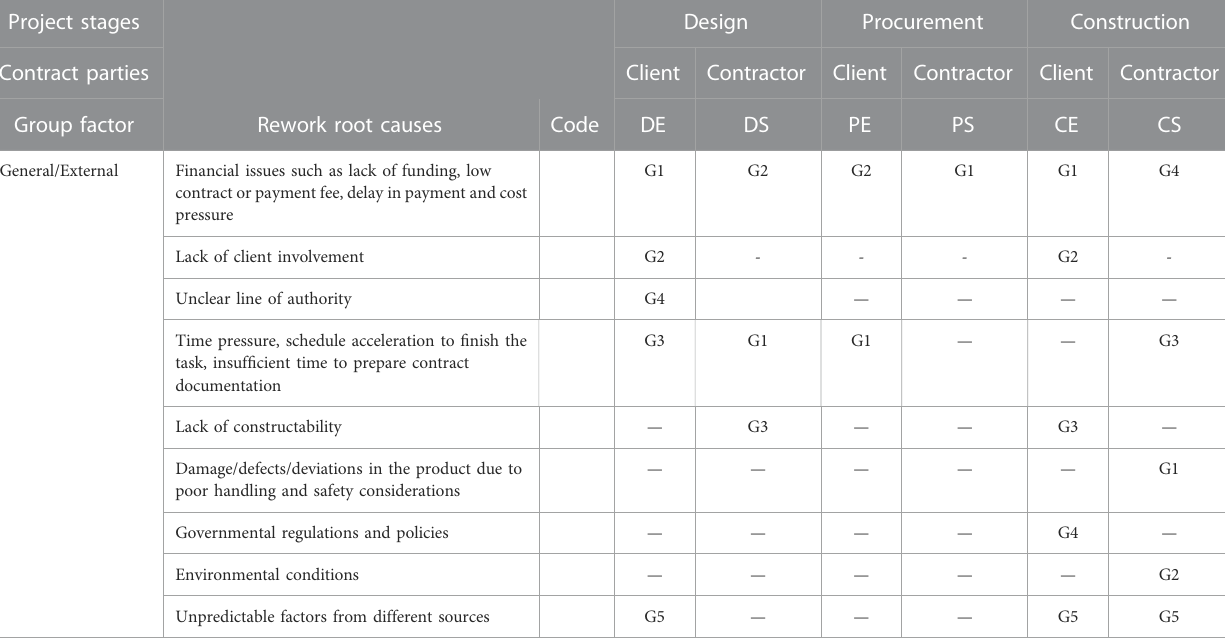
TABLE 8 ( Continued ) List of rework causes in three stages of the project with liable contract parties.